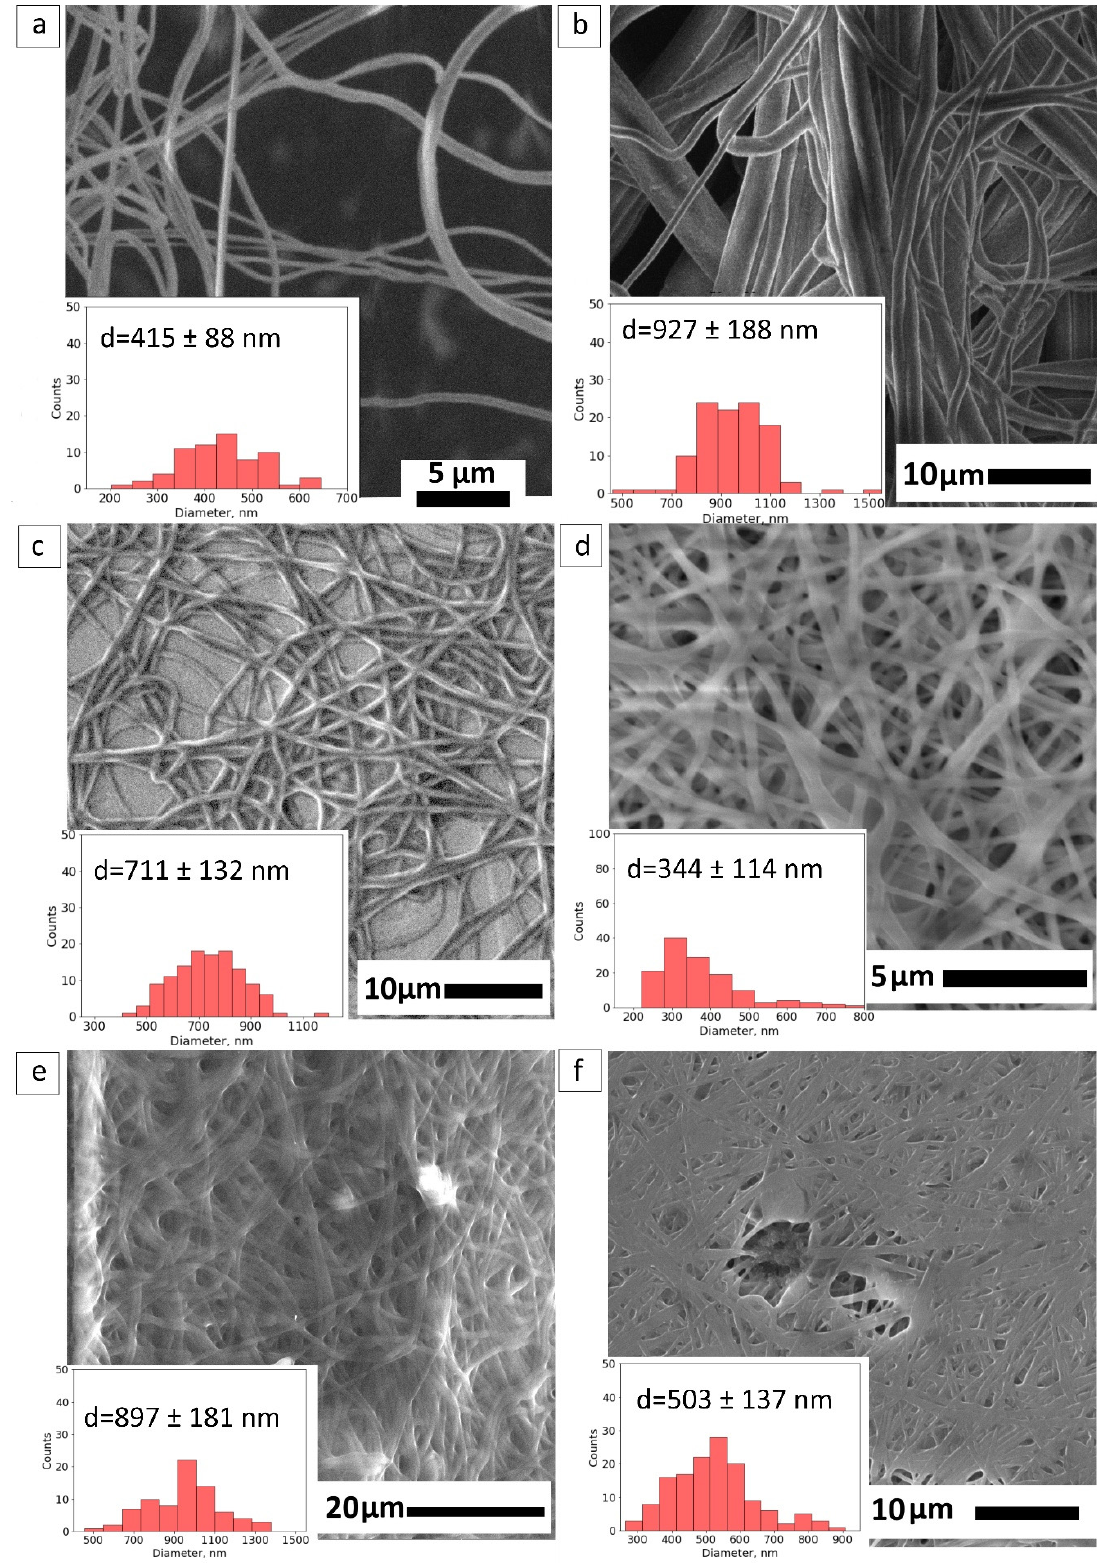
Figure 3. SEM imaging of crosslinked fibers with methanol: ( a ) pristine PVA; ( b ) PVA-PEG core; ( c ) PVA–PEG–SiO 2 core; ( d ) shell PVA–GO 10%; ( e ) core-shell PVA-PEG@PVA–GO); and ( f ) core-shell PVA–PEG–SiO 2 @PVA–GO.